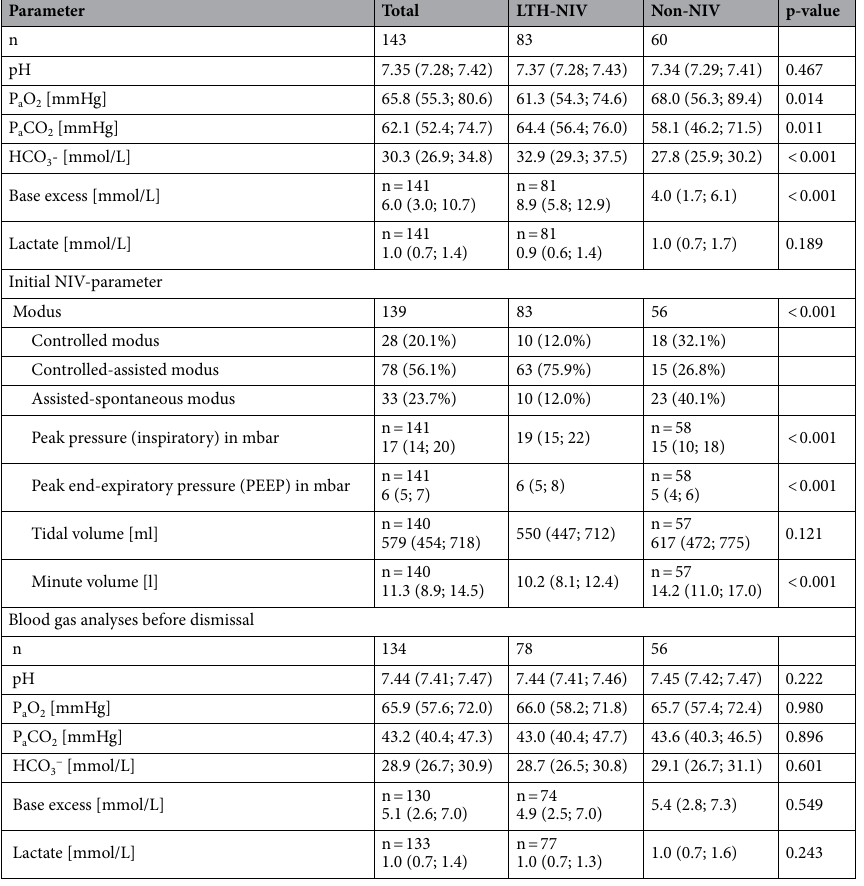
Table 2. Blood gas findings, and NIV modes/parameters during hospitalization. PaO 2 partial pressure O 2 ; P a CO 2 partial pressure CO 2 ; HCO 3 − standard bicarbonate.